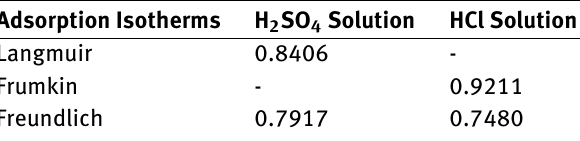
Table 5: Comparison of correlation coeflcient values of Langmuir, Frumkin, Freundlich and Temkin adsorption isotherms from H 2 SO 4 and HCl solution